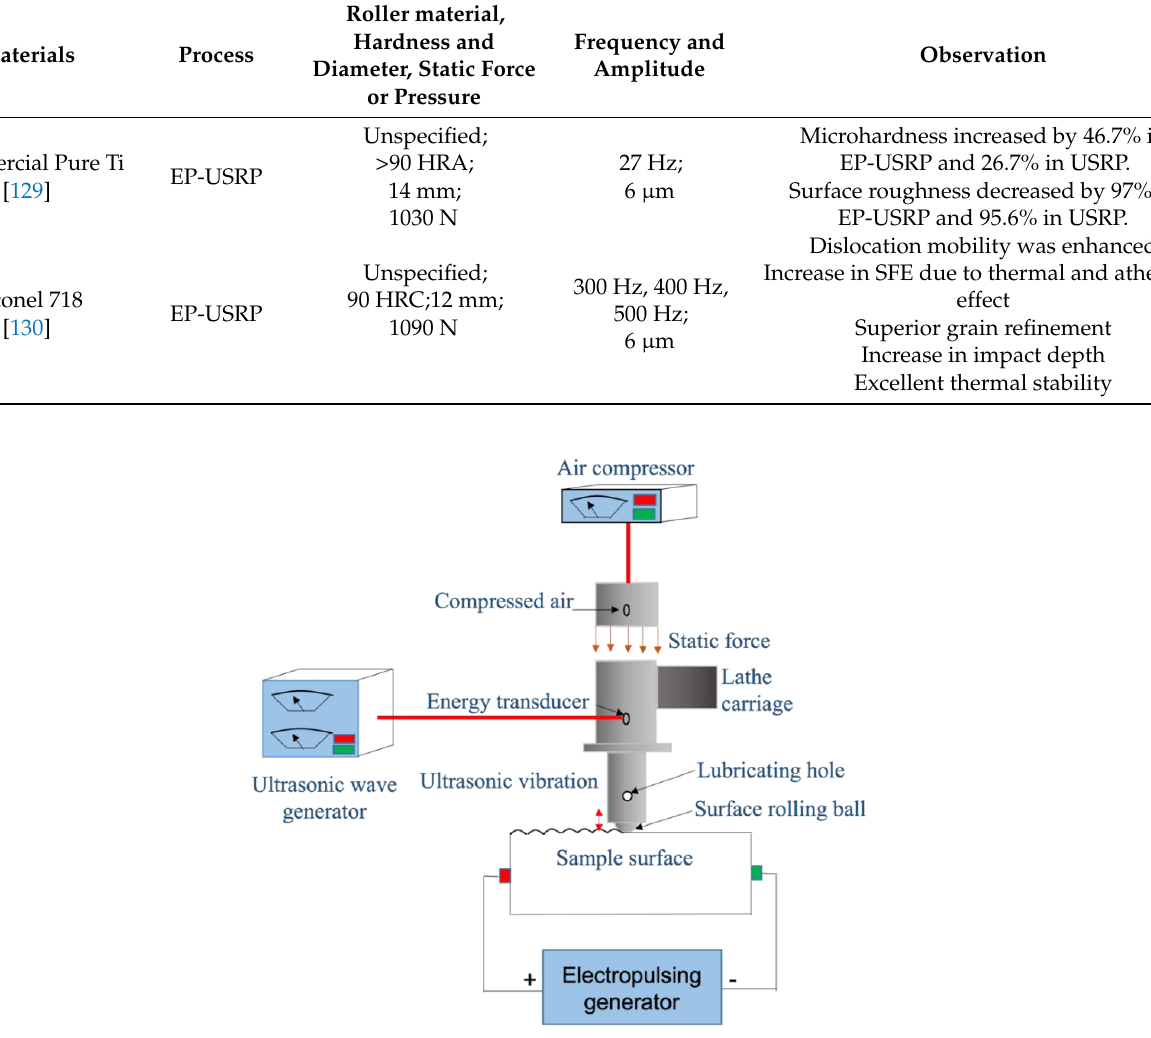
Figure 18. Schematic of the EP-USRP.